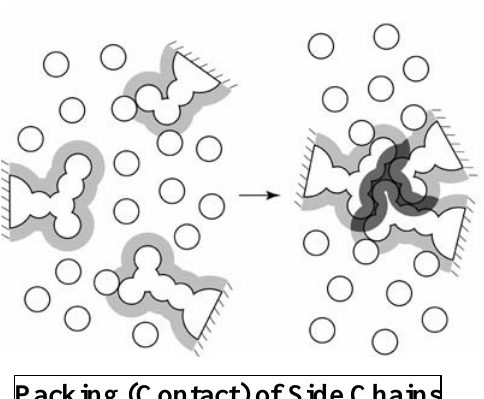
Figure 1. The presence of a side chain generates an excluded volume (EV) which the centers of water molecules cannot enter. The EV is the volume occupied by the side chain itself plus the volume shown in gray. When side chains are closely packed (or contact one another), the EVs overlap and the total volume available to the translational movement of water molecules in the system increases by the overlapped volume shown in black, leading to a gain of the water entropy. It has been argued for a solute with cylindrical shape generating an EV that the formation of the helical structure by a cylinder or the lateral contact of cylinders leads to a reduction of the EV [6,7]. This argument can be applied to the backbone of a protein. The construction of the  -helix accompanies not only a formation of the helical structure by a portion of the backbone but also the contact of side chains. The lateral contact of portions of the backbone and the contact of side chains occur in the construction of the  -sheet. Thus, the construction of these secondary structures leads to a reduction of the EV followed by a corresponding gain of the water entropy